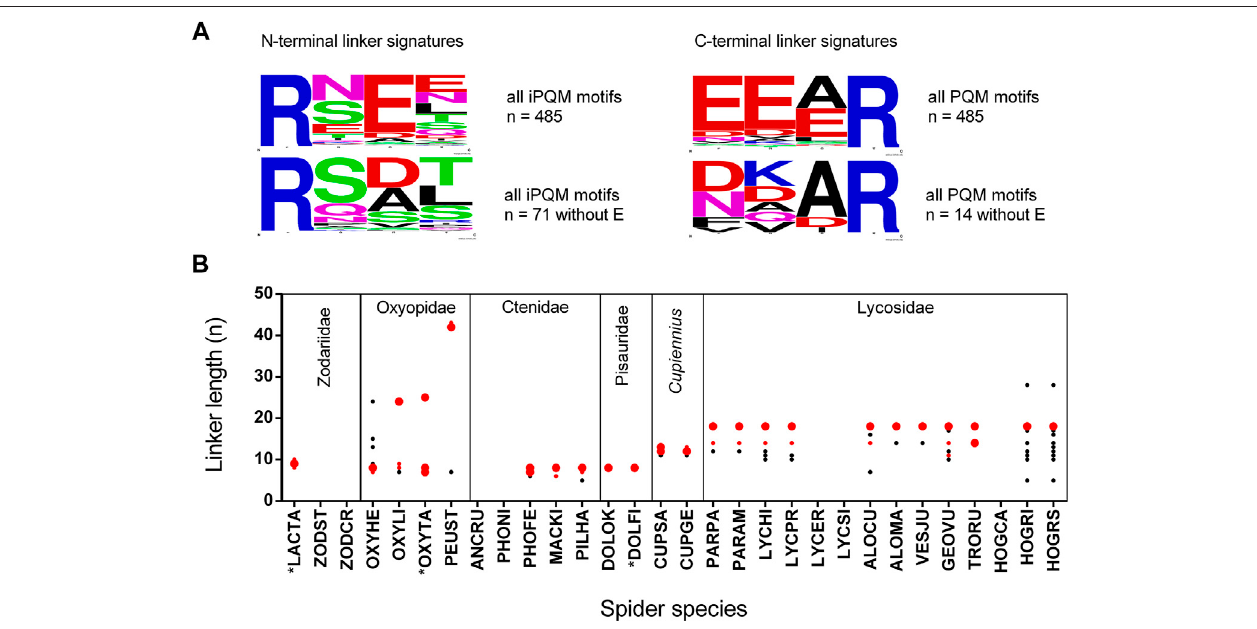
FIGURE 4 | Signature, length, and abundance of linkers identi fi ed in binary/complex precursors of different spider families. (A) N-terminal (iPQM) and C-terminal (PQM)signaturesofallidenti fi edlinkersinthepresenceorabsenceofGlu.TherelativefrequencyofeachaminoacidresidueatacertainpositionofdifferentN-terminiand C-terminiisgivenasasequencelogo.Cationicaminoacidsaregiveninblue,anionicaminoacidsinred,AsnandGlninpink,polaraminoacidsingreen,andhydrophobic amino acids in black. (B) Six spider families with the investigated species: The linker length is given as amino acid residues per peptide (n). The abundance of all linkers within a species is illustrated as big red dots ( > 30%), small red dots ( > 20%), and black small dots ( < 20%). *Data are from [A0A5J6SEB1, A0A5J6SEE5, A0A0K1D8Z3, Q1ELU5, Q1ELU4, Q1ELU8]. Species abbreviations are in alphabetical order: ALOCU, Alopecosa radiata ; ALOMA, Alopecosa marikovskyi ; ANCRU, Ancylometes rufus ; CUPGE, Cupiennius getazi ; CUPSA, Cupiennius salei ; DOLFI, Dolomedes fi mbriatus ; DOLOK, Dolomedes oke fi nokensis ; GEOVU, Geolycosa vultuosa ; HOGCA, Hogna carolinensis ; HOGRI, Hogna radiata (Italy); HOGRS, Hogna radiata (Spain); LACTA, Lachesana tarabaevi ; LYCER, Lycosa erythrognatha ; LYCHI, Lycosa hispanica ; LYCPR, Lycosa praegrandis ; LYCSI, Lycosa singoriensis ; MACKI, Macroctenus kingsleyi ; OXYHE, Oxyopes heterophthalmus ; OXYLI, Oxyopes lineatus ; OXYTA, Oxypes takobius ; PARAM, Pardosa amentata ; PARPA, Pardosa palustris ; PEUST, Peucetia striata ; PILHA, Piloctenus haematostoma ; PHOFE, Phoneutria fera ; PHONI, Phoneutria nigriventer ; TRORU, Trochosa ruricola ; VESJU, Vesubia jugorum ; ZODCY, Zodarion cyrenaicum ; ZODST, Zodarion